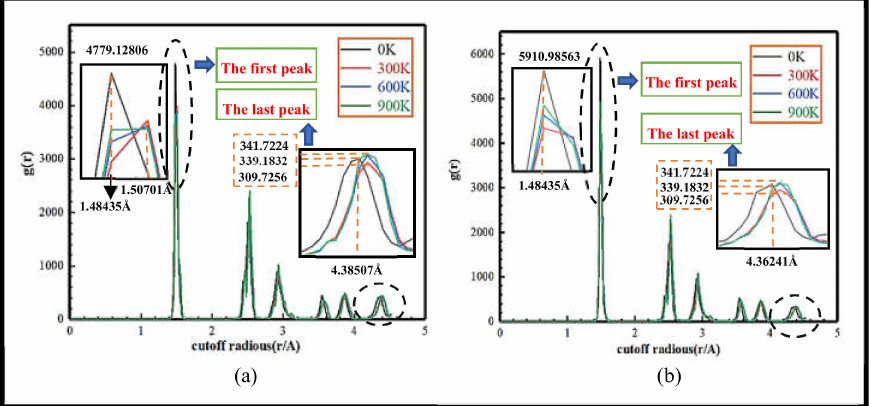
Figure 2. Radial distribution curve at different temperatures. ( a ) Radial distribution function of 2 nm, ( b ) Radial distribution function of 10